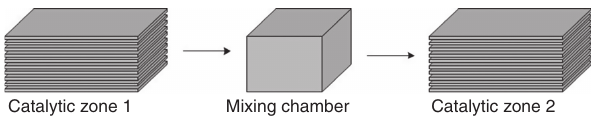
Figure 5 Schematic representation of the reaction space inside the